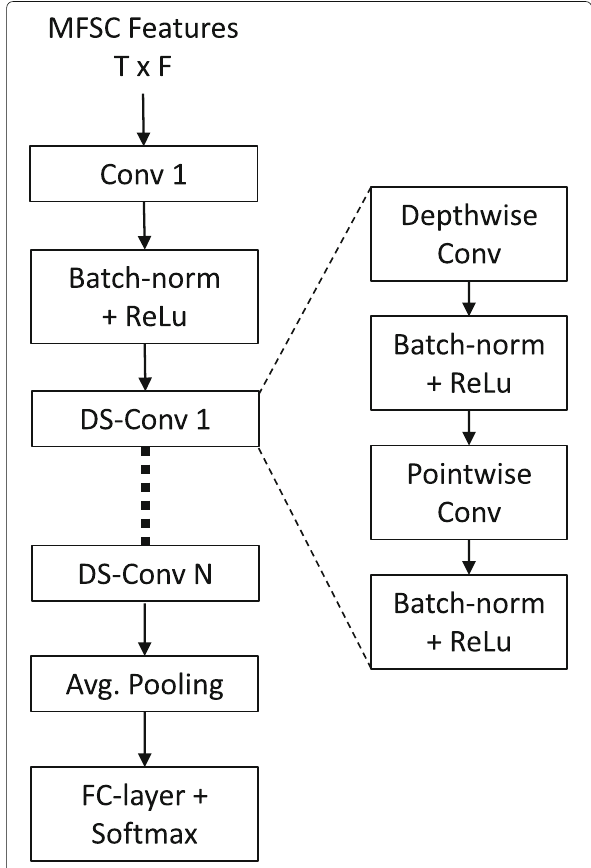
Fig. 3 General architecture of the DS-CNN. The input feature map is passed onto the first convolution layer, followed by batch normalization and ReLU activations. The following DS-convolution layers 1-N each consist of a depthwise convolution, followed by batch-normalization and ReLU activation, passed on to a pointwise convolution and another batch normalization and ReLU activation. At the end of the convolutional layers, the output undergoes average pooling and a fully connected (FC) layer with softmax activations